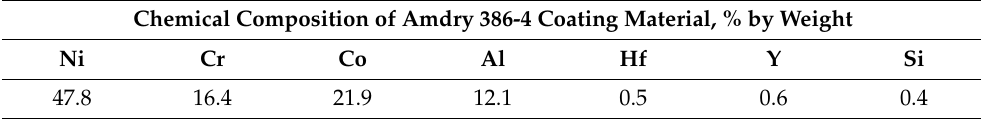
Table 2. Chemical composition of Amdry 386-4 coating material.